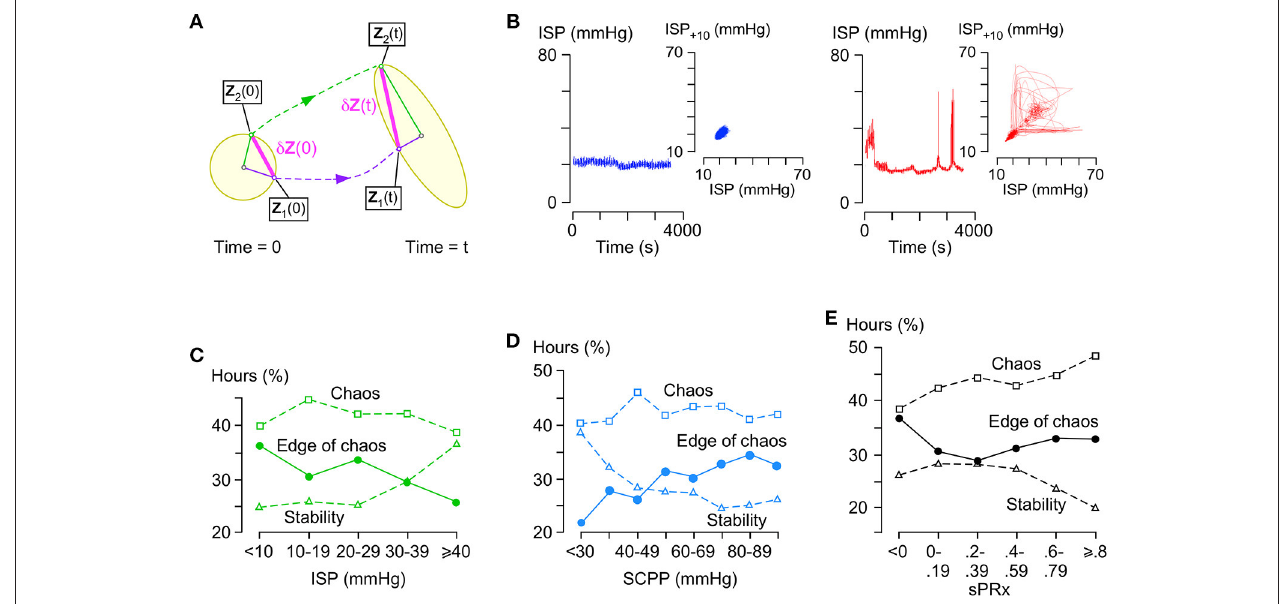
FIGURE 4 | Stability analysis of ISP signal. (A) Concept of Lyapunov exponents: In phase space, a small n-dimensional sphere with radius p 1 ( 0 ) = p 2 ( 0 ) = ... = p n ( 0 ) at time 0 becomes an ellipsoid with radii p 1 ( t ) , p 2 ( t ) , ... , p n ( t ) at time t. The i-th Lyapunov exponent is defined